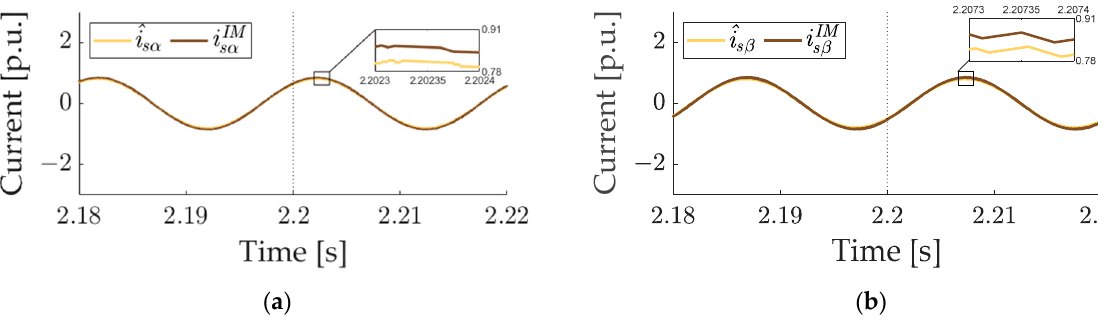
Figure 9. Estimated and IM components α ( a ) and β ( b ) of the stator current for k 0 = 1 and faulty CS in phase A , ε i = 0.02845.